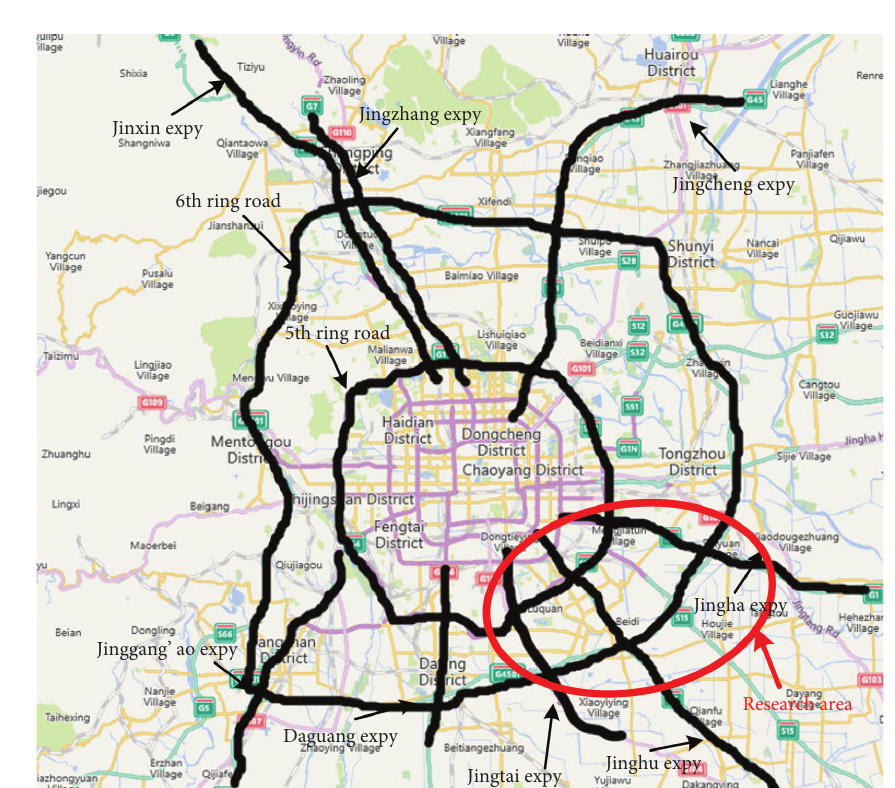
Figure 3: Adjacent region between the highway and urban expressway.